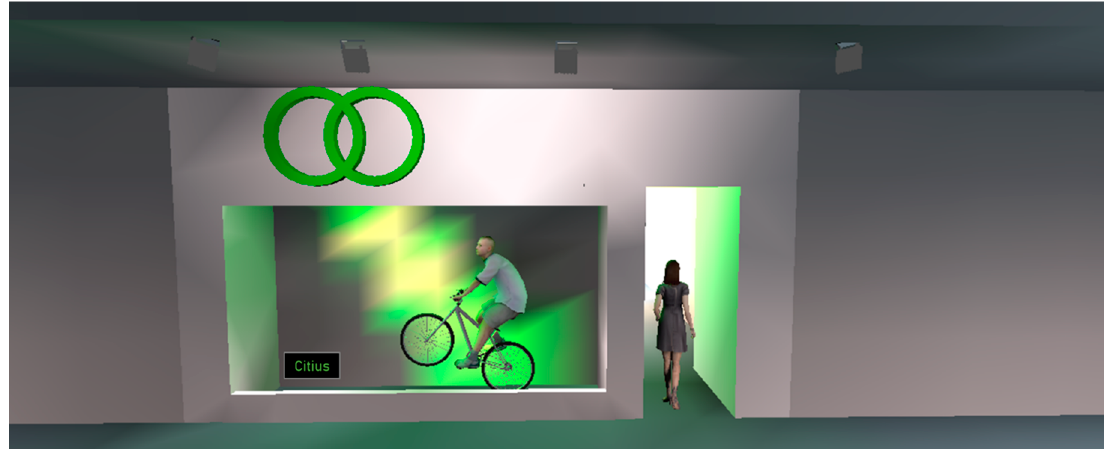
Figure 36. Fast communication at a glass case indicating the Olympic motto—Scene 2.